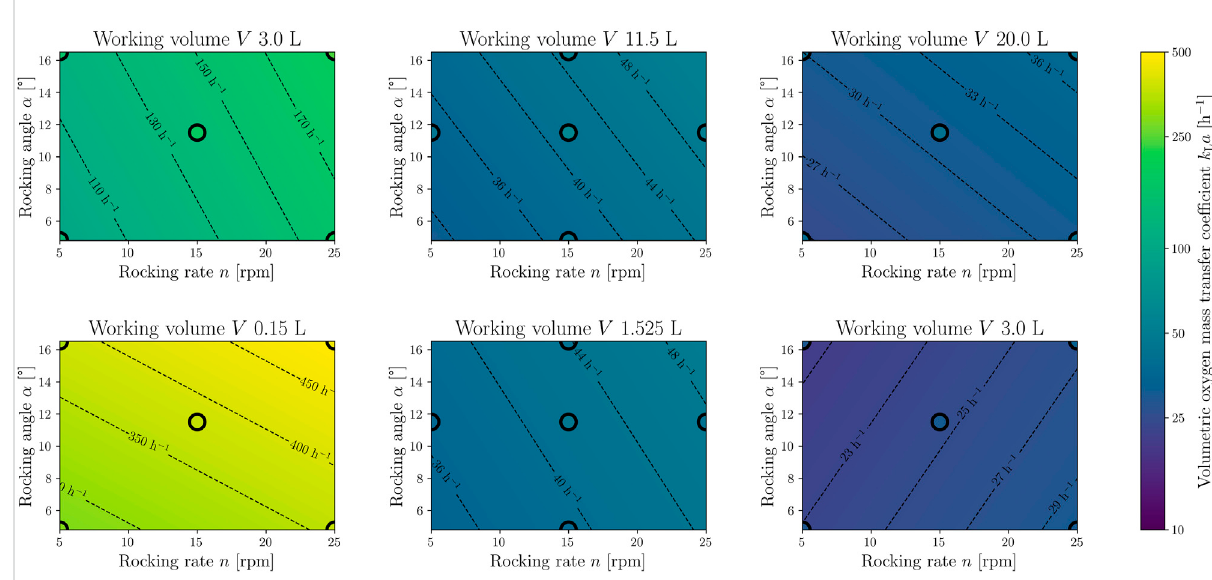
FIGURE 10 Response surface model (RSM) for the time-averaged volumetric oxygen mass transfer coef fi cient. The top row shows the model for the standard CELL-tainer con fi guration ( N = 15, DF = 9, R 2 = 0.99, RMSE = 1.77 h − 1 ) with three different working volumes (3.0 L, 11.5 L and 20.0 L). The lower row shows the RSM ( N = 15, DF = 9, R 2 = 0.99, RMSE = 1.94 h − 1 ) for the con fi guration with expansion channels (0.15 L, 1.525 L and 3.0 L). The blackcirclesmarkprocessparametersettingsonwhichCFDsimulationswereperformedtocreatethemodel,andthe fi llingcolorcorresponds to the exact value of the CFD